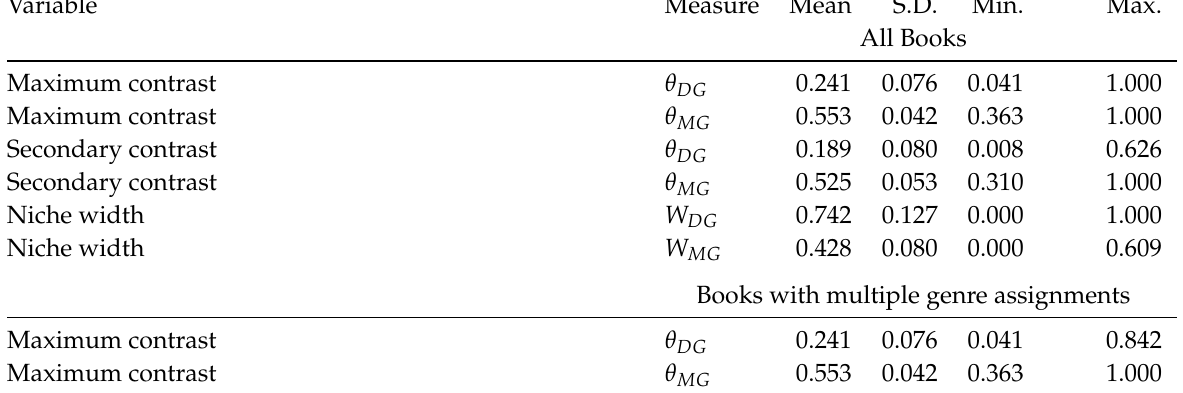
Table 1: Distributions of theoretically relevant variables with alternative measurements